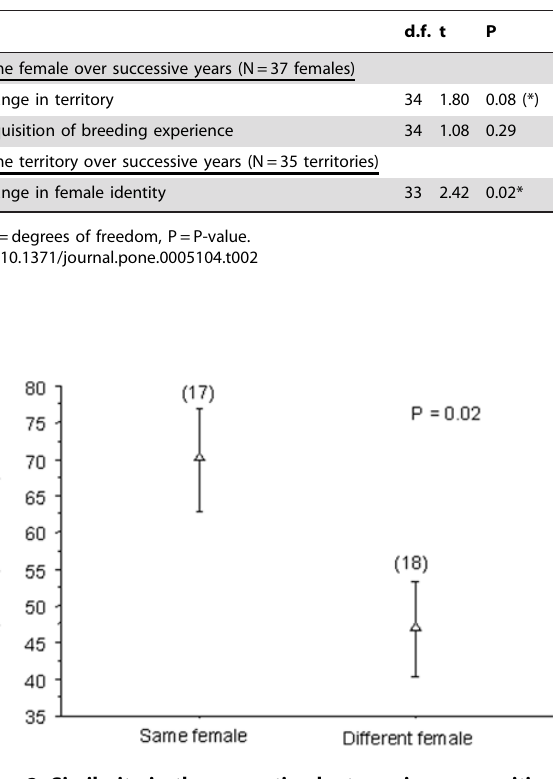
Figure 2. Similarity in the aromatic plant species composition of nests from breeding attempts made in the same territory, either by the same female or by different females. Similarity was calculated using the Bray-Curtis index. Sample sizes are indicated in parentheses. The P-value results from a Student’s t-test (see Methods).